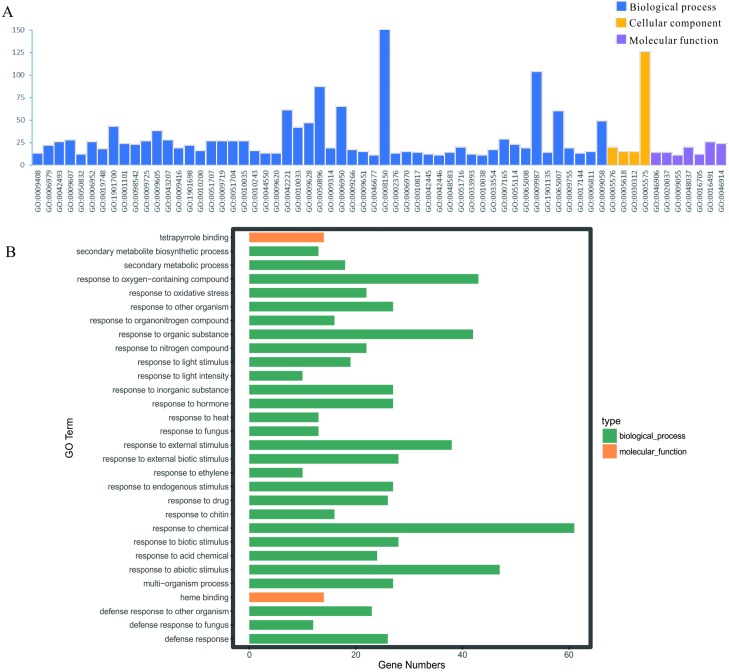
GO enrichment analysis of the screened DEGs.(A) GO enrichment divided DEGs into three functional group: molecular function, biological processes, and cell composition. (B) GO enrichment significance items of DEGs in different functional groups.